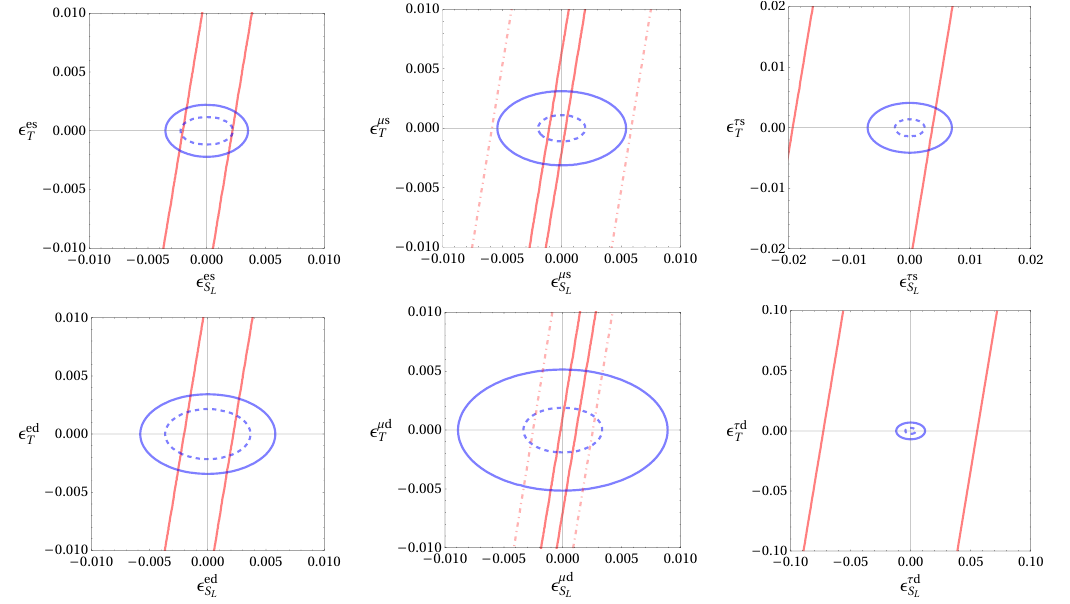
and (cid:15) αβi to the charmed-meson decay data S L T